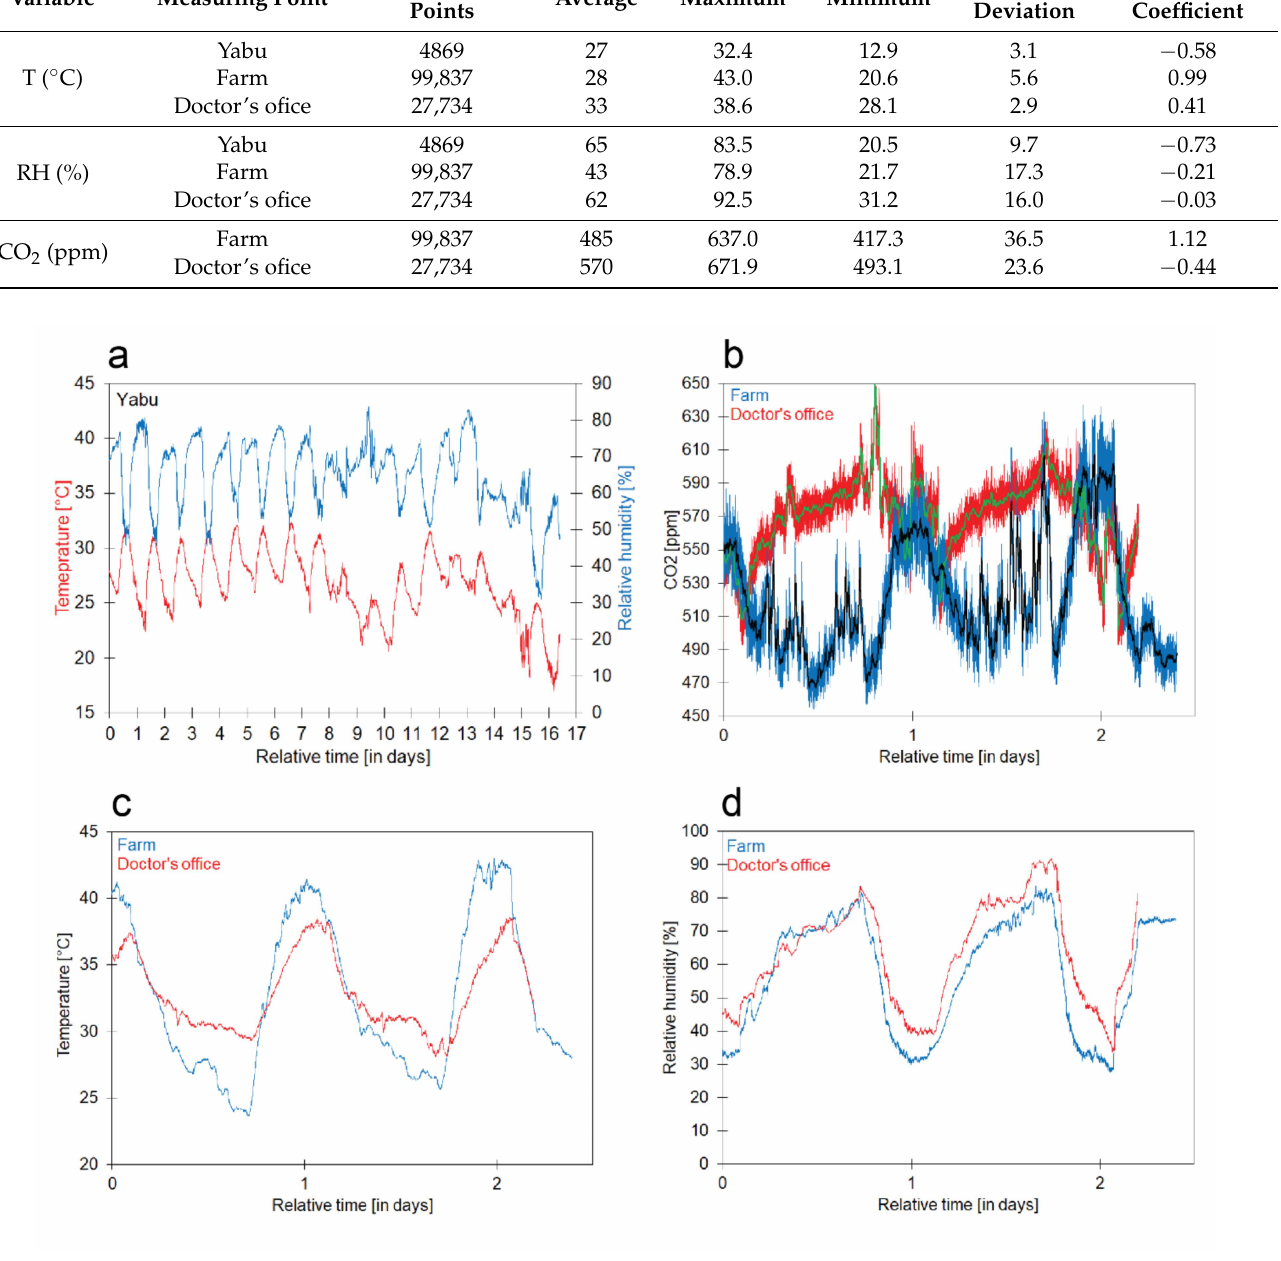
Figure 14. Corrected sensor data for T and RH in the field test at the Yabu site during 14–29 February 2020, and the parallel measuring campaigns at the farm and the doctor’s office during 4–6 November 2020; ( a ) results of the campaign in Yabu; ( b ) CO 2 trends at the farm and the doctor’s office with a central moving average and a window width of 10 min; ( c ) superimposed temperate trends of the farm and doctor’s office; ( d ) superimposed RH trends of the farm and doctor’s